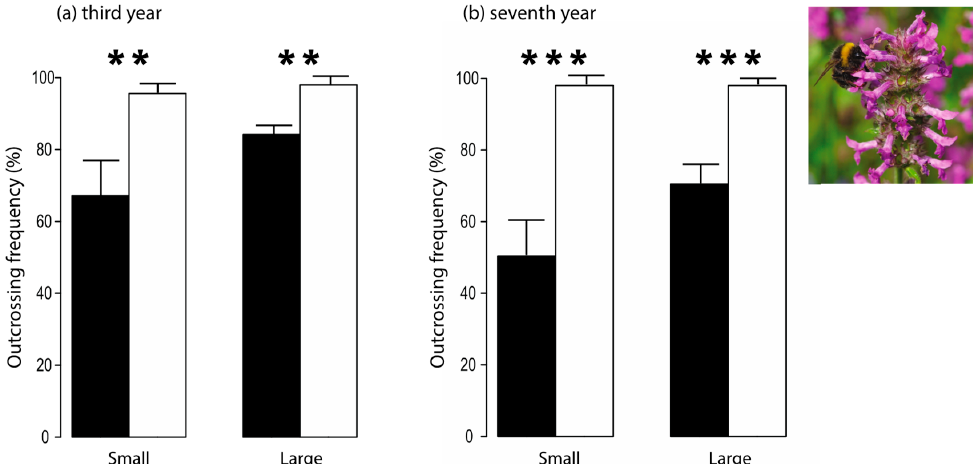
Figure 8. Frequency of outcrossing in S. officinalis in small and large fragments (black bars) and the corresponding control plots (open bars) in the third year ( a ), and seventh year ( b ) of experimental fragmentation. Means ± SE are shown; n = 7; ** p < 0.01, *** p < 0.001. Data from Rusterholz and Baur [41].